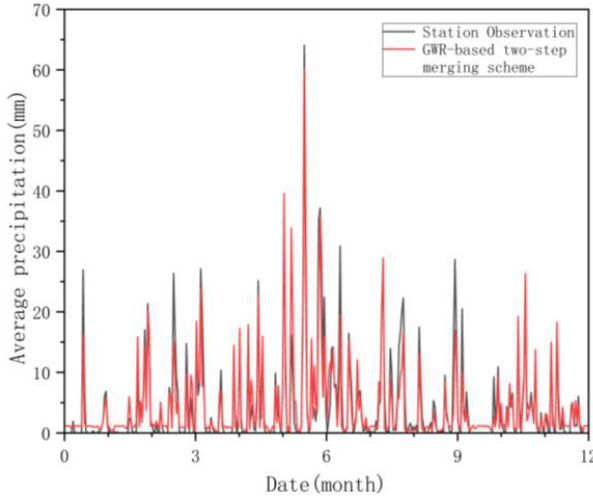
Figure 10. Time series of areal-average daily precipitation of gauge observation and estimated precipitation for 2015.